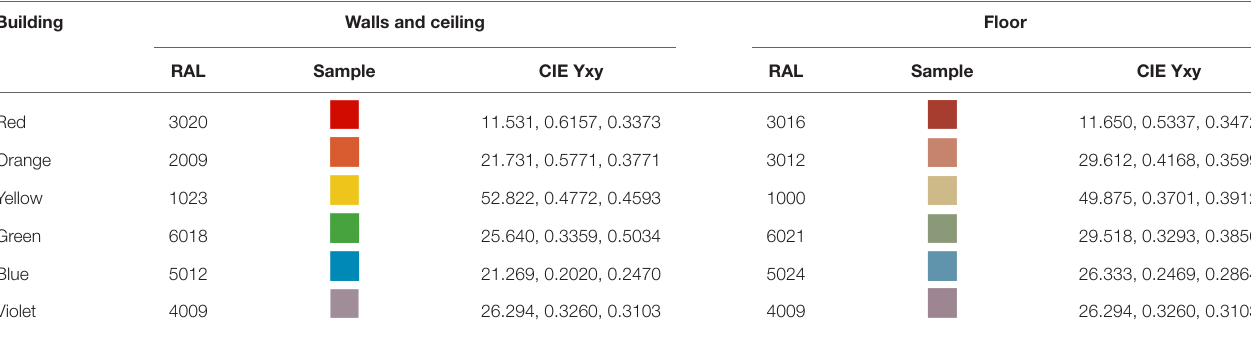
TABLE 1 | RAL code, color sample, and CIE Yxy coordinates for walls, ceilings, and floors of the six buildings considered in the study.